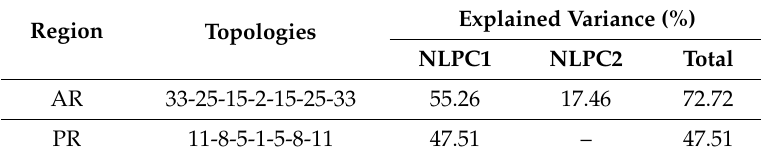
Table 1. Topologies and explained variance for the Andean Region (AR) and the Pacific Region (PR) using the NLPCA approach.